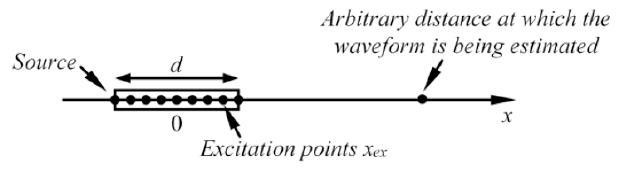
Figure 1. The analyzed 1D guided wave excitation case.